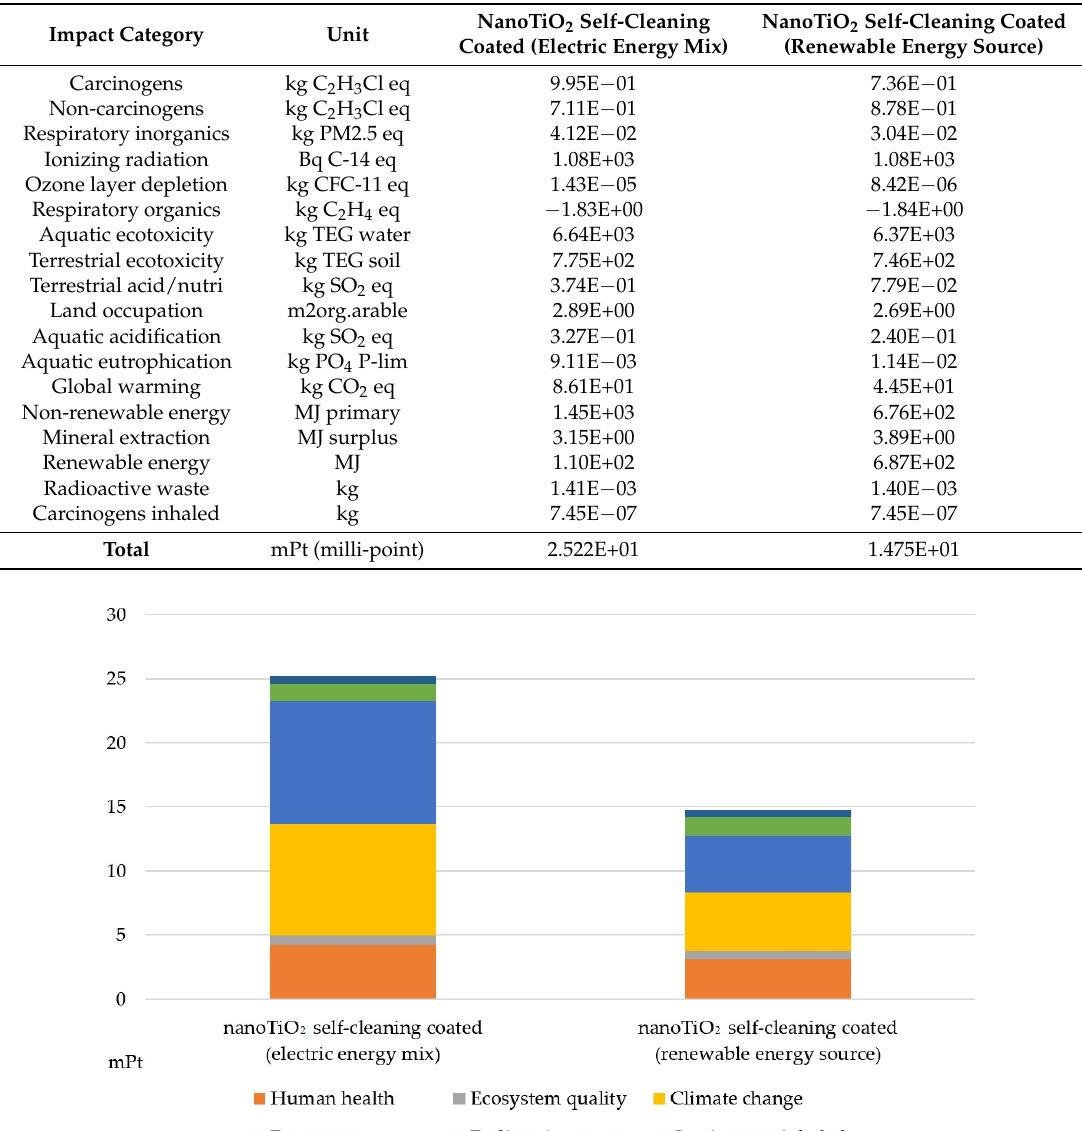
Table 4. Environmental comparison between 1 m 2 of nanoTiO 2 self-cleaning coated glass using electric energy mix and 1 m 2 of nanoTiO 2 self-cleaning coated glass using renewable energy sources.